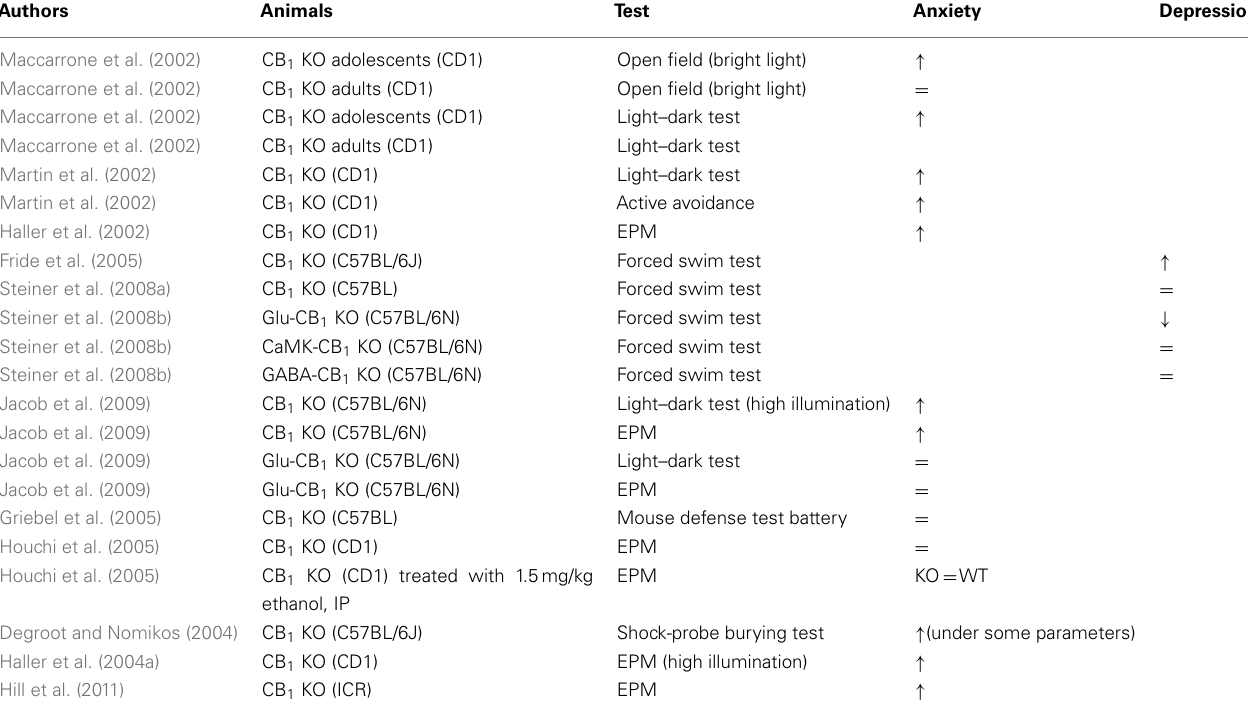
Table 2 | Summary of studies investigating anxiety-like and depression-like behavior in knockout with cannabinoid CB 1 with deleted.